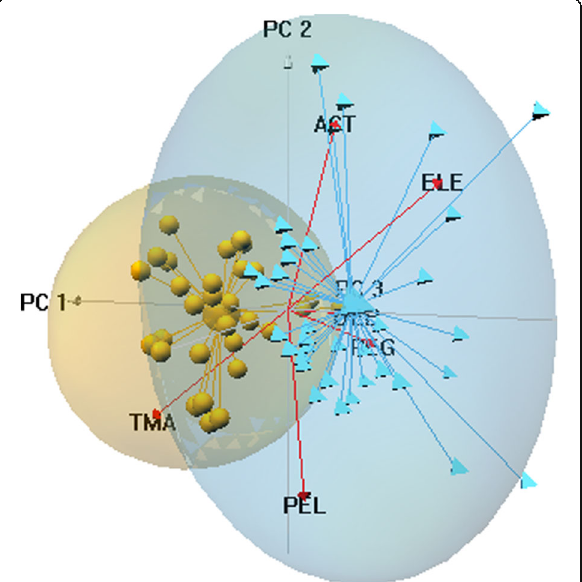
Fig. 2 Principal component analysis scatter-plot, representing the multidimensional niche opposing the sites of presence and absence. The ellipsoids represented the 95% confidence intervals. Blue triangles, presence; orange circles, absence. Explained variance PC 1 =11.02%, PC 2 =9.24%, PC 3 =7.89%. To improve clarity, it is shown only these variables with the highest absolute loadings: ACT (aciculifolious tree), ELE (elevation, masl), PEG (perennial grass), PEL (perennial liana),